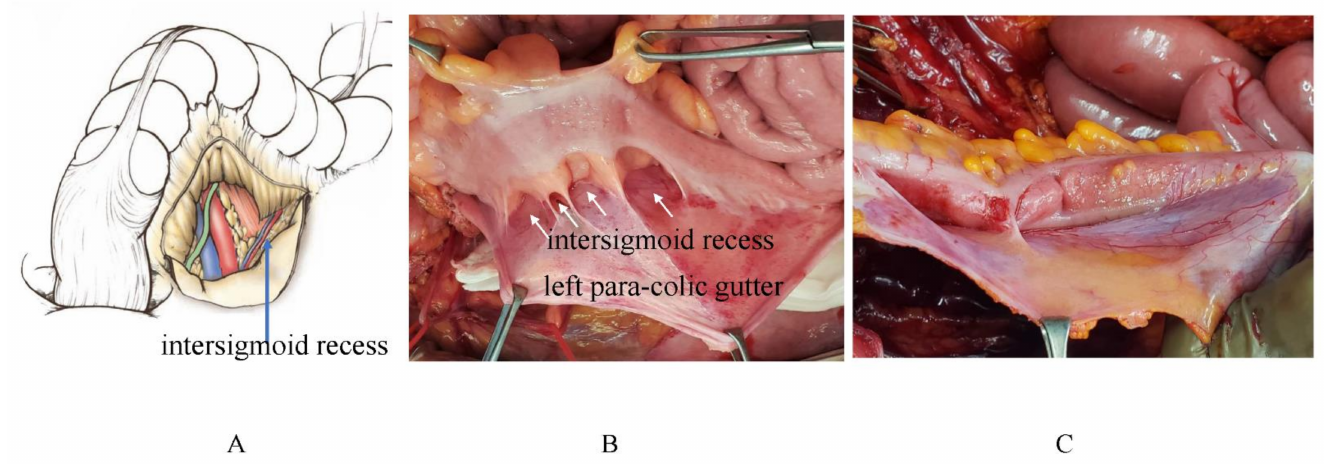
Figure 28. ( A , B ) Left side of the sigmoid mesocolon has an intersigmoid recess. ( B ) This case has four intersigmoid recesses. ( C ) Metastases on the intersigmoud recess and left para-colic gutter are removed by